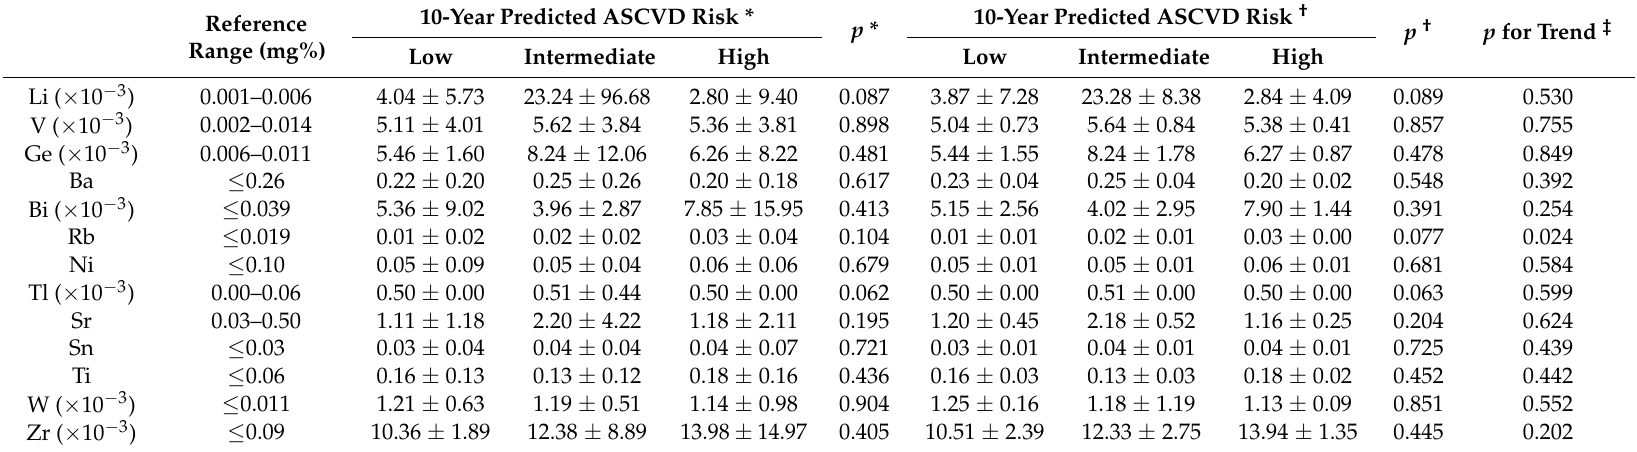
Table 3. Concentrations of thirteen additional elements in hair in the three groups of subjects stratified by severity of ASCVD risk.